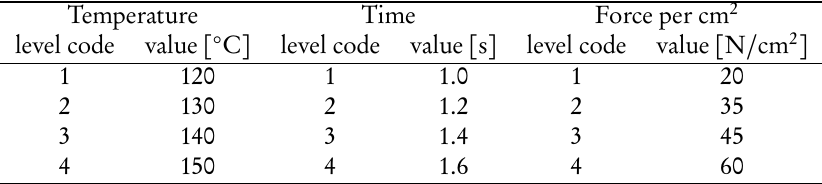
Levels of control factors selected for the experimental